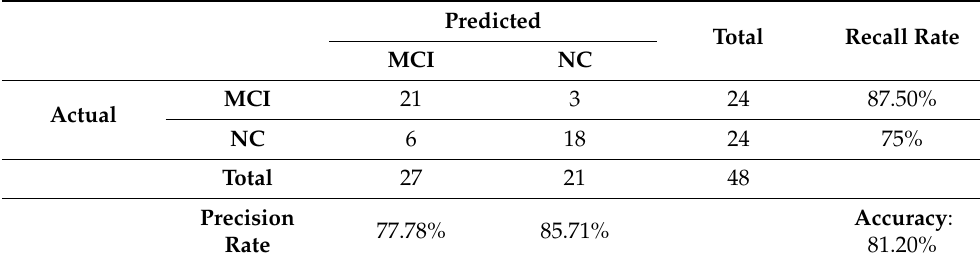
Table 9. Confusion Matrix with Precision and Recall rates using both HRV and game